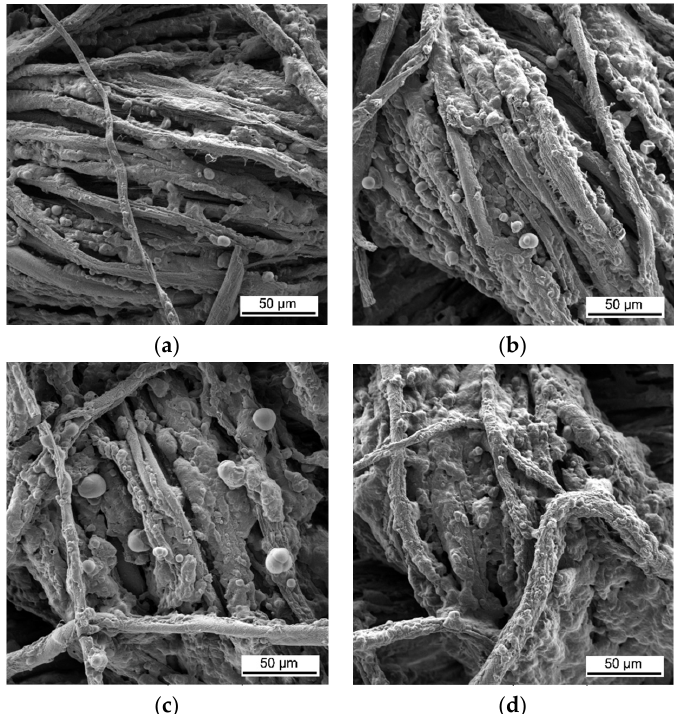
Figure 6. SEM images of the char residue of treated cotton after performing vertical flame testing: ( a ) 8, ( b ) 10, ( c ) 12, and ( d ) 15 BL.